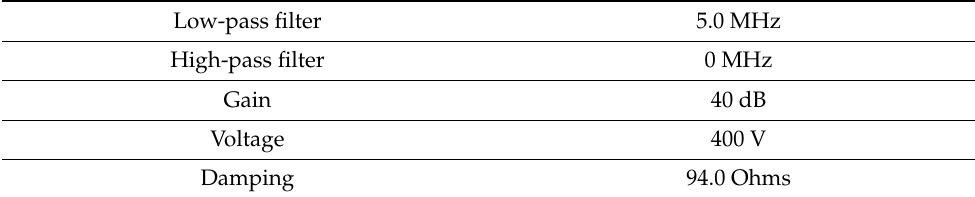
Table A2. Experiment